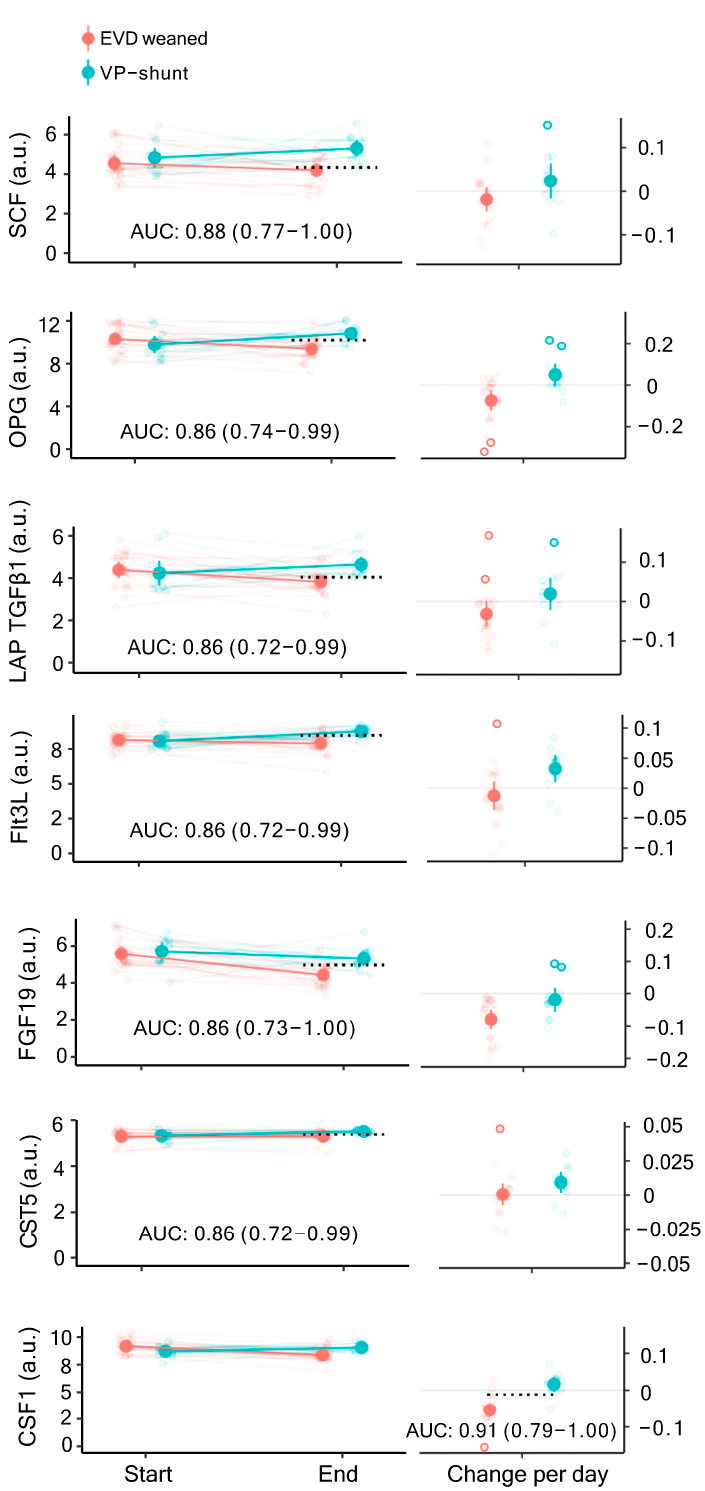
Figure 2. Valid predictors of shunt dependency. The abundance of the inflammatory markers in the start vs. end sample is shown in the left column, with AUCs (AUC: arbitrary units with 95% CI), and the daily change in abundance illustrated in the right column). Dashed lines show Youden’s threshold as a cutoff for sensitivity and specificity for the given marker. EVD weaned: n = 19; VP-shunt: n = 12; AUC: area under the curve; CI: confidence interval.